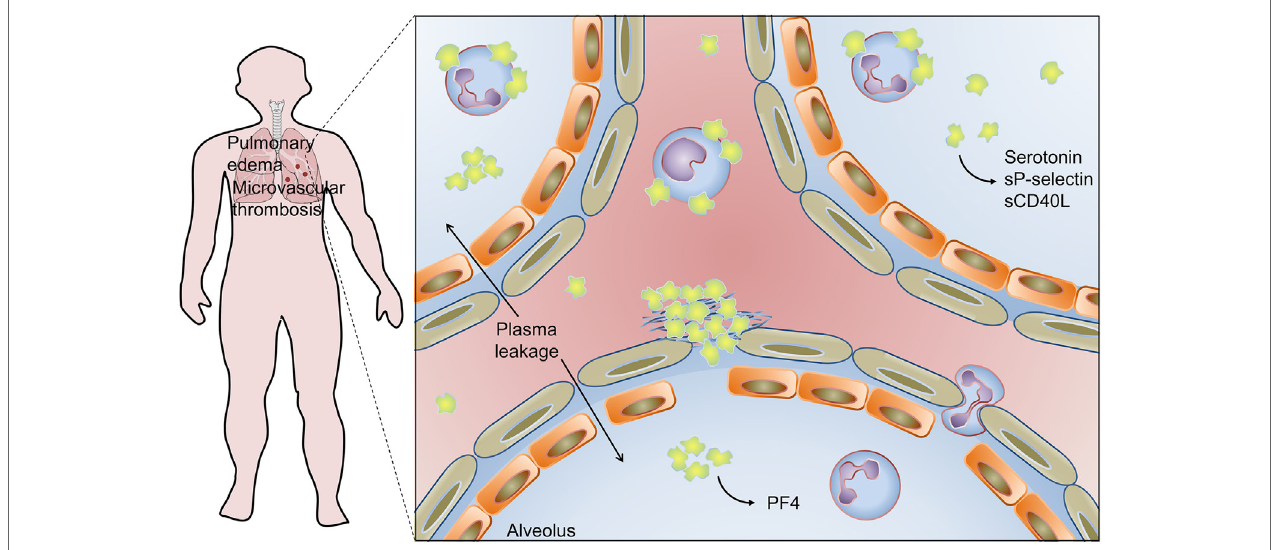
FigURe 4 | Platelet activation and infiltration to airways in influenza pneumonia: pulmonary edema and microvascular thrombosis with platelet–fibrin clot deposition in areas of disrupted alveolar-capillary barrier integrity are histopathological features of influenza pneumonia. Platelets, platelet–platelet aggregates, and platelet– neutrophil aggregates have been also detected in extravascular space in the lungs, and platelet–monocyte aggregates have been demonstrated in circulation. Activated platelets secrete serotonin, sCD40L, sP-selectin, and PF4 in the airways. Platelet activation is involved in pathophysiologic mechanisms of lung injury and pulmonary edema in influenza. On the other hand, platelet secretion of PF4 is an essential mechanism for neutrophil recruitment to the lungs and innate immunity against influenza virus. See the text for details and